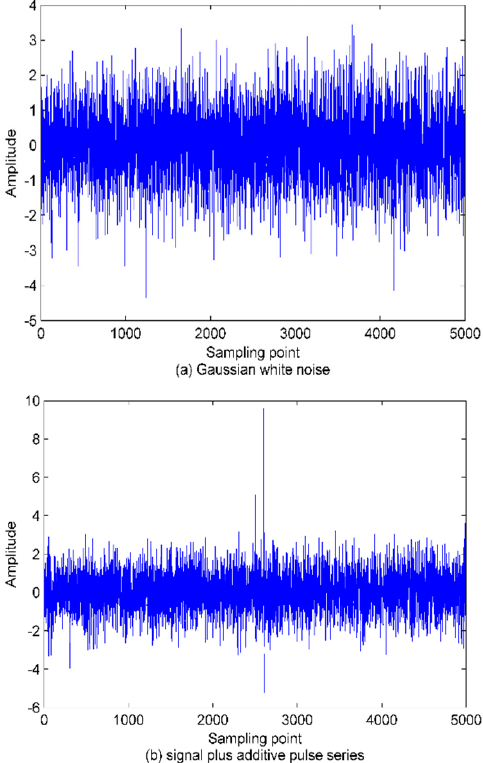
Figure 5. The time domain diagrams of Gaussian white noise and the signal plus additive pulse series. ( a ) Gaussian white noise; ( b ) signal plus additive pulse series.